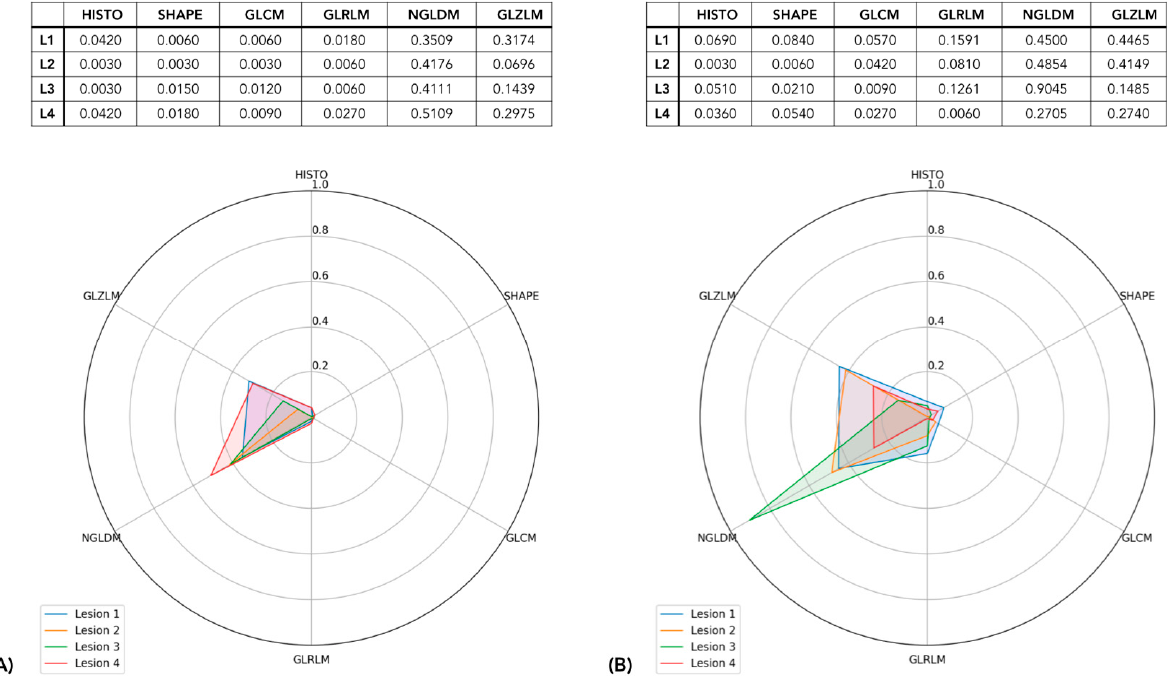
Figure 4. The lesion profiles of two patients. Each lesion is represented by the 6 depth measures related to each radiomic view. Depth values as listed in the tables are graphically represented in spider plots. In ( A ), the patient (#17) exhibited only one radiomic pattern; in ( B ), the patient (#31) showed two different shapes in the lesion radiomic profile.